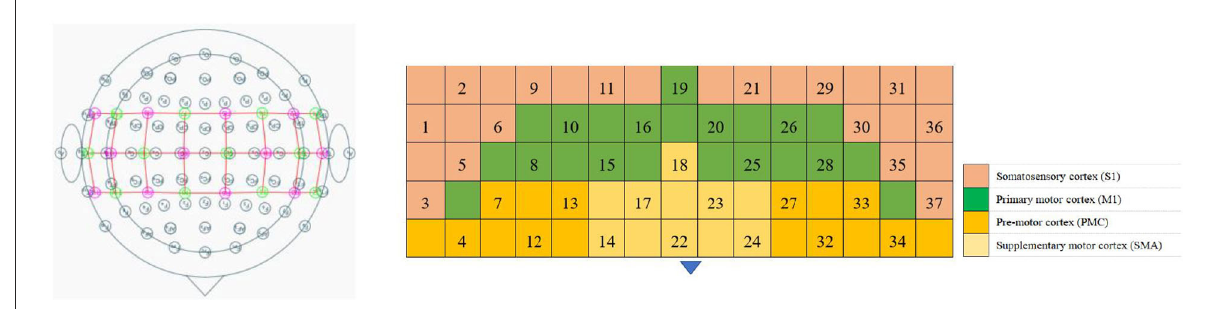
FIGURE1 Schematic diagram of fNIRS channel registration with brain regions.